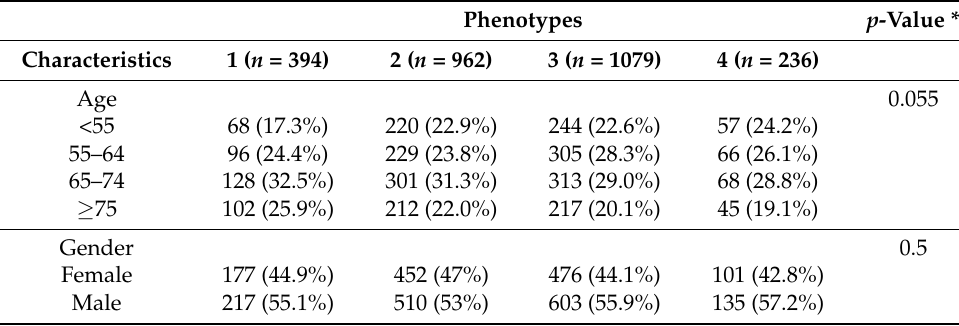
Table 2. Univariate